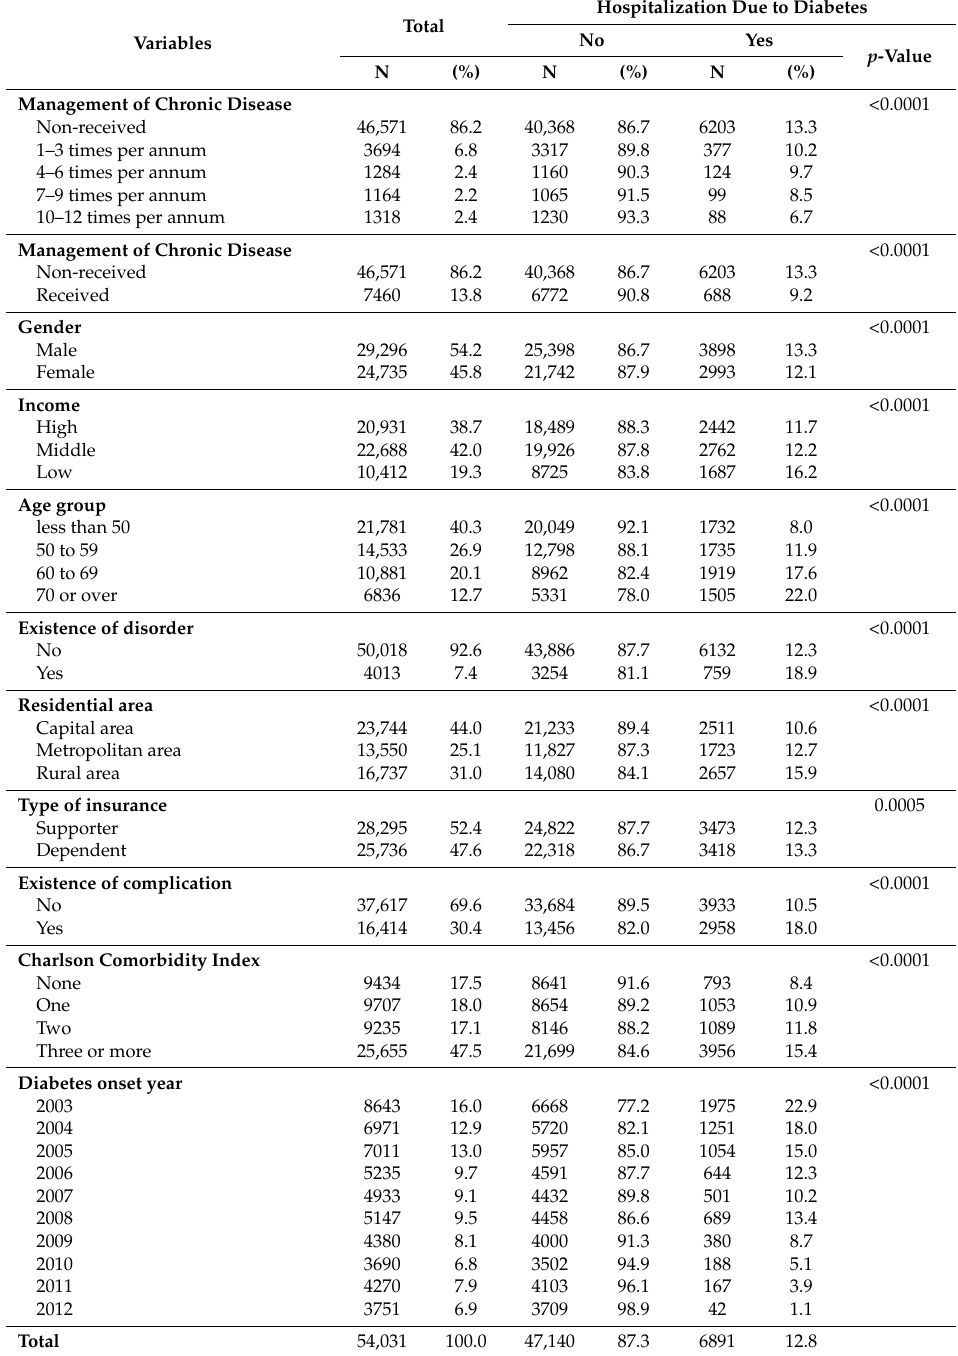
Table 1. General characteristics of the study